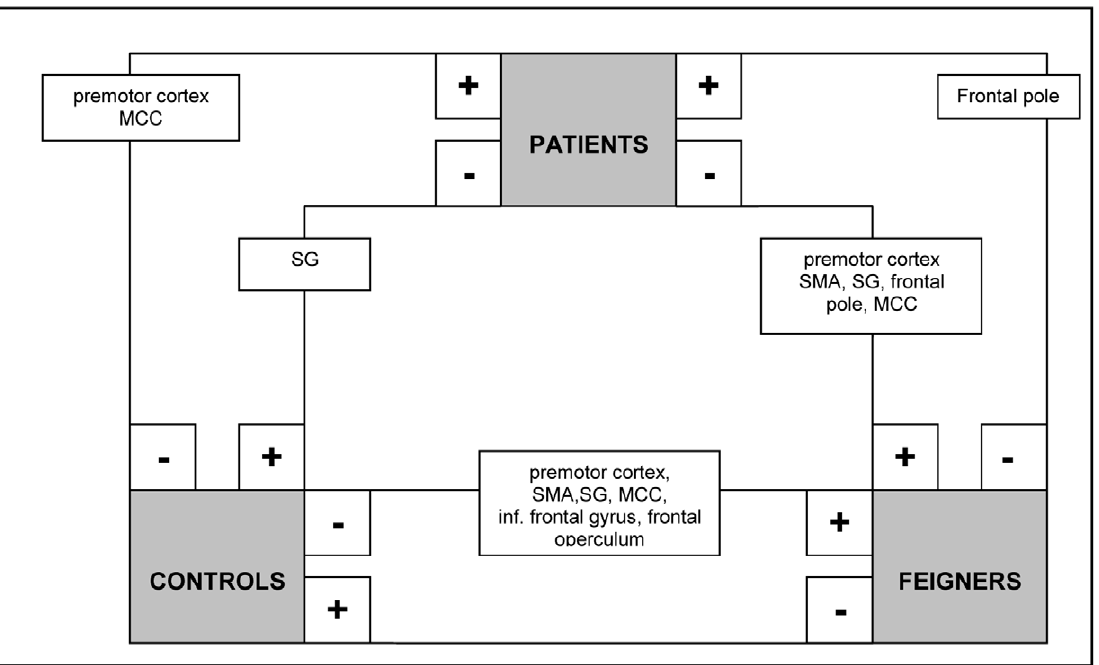
Figure 3. Schematic summary of significant clusters (P , 0.05, whole-brain corrected at cluster level; k . 200) in between-group comparisons (flipped data): movement execution in the unaffected hand (analysis C). + =significantly more activated than -.